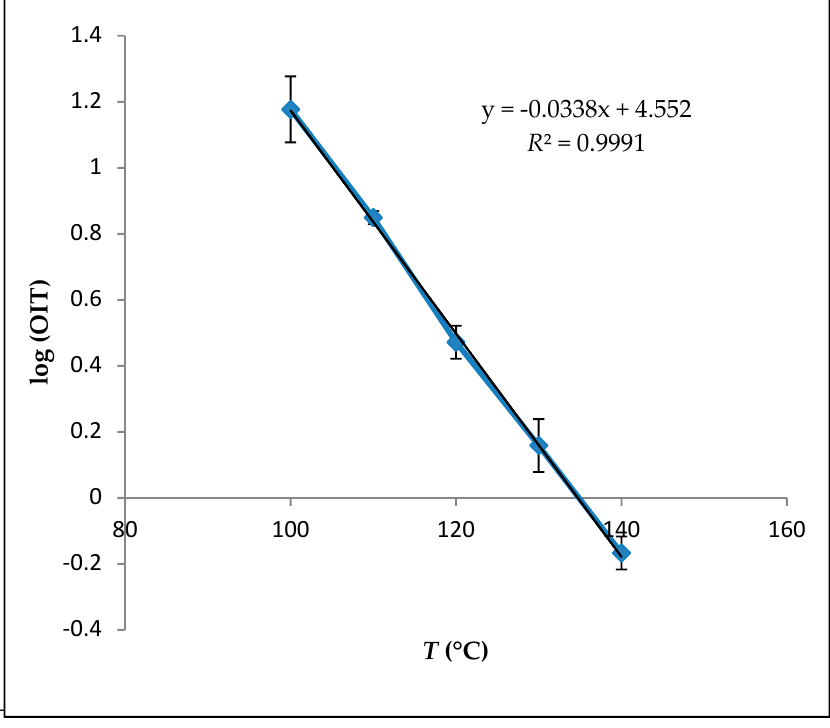
− Figure 2. The linear relationship between the natural logarithm of the oxidation induction time (OIT) and the temperature.